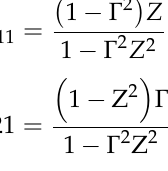
Figure 1. 7 × 7 I-shaped MTM array: ( a ) geometrical configuration, ( b ) fabricated structure.